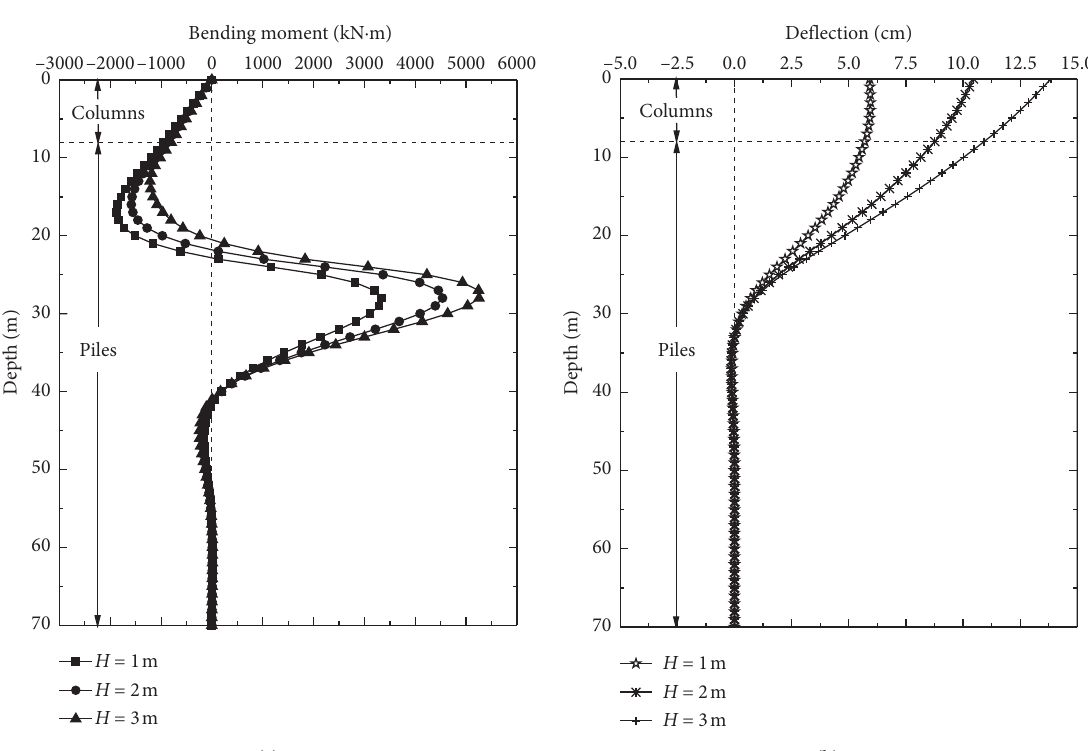
Figure 11: Effect of H on the piles-columns response. (a) Bending moment. (b)